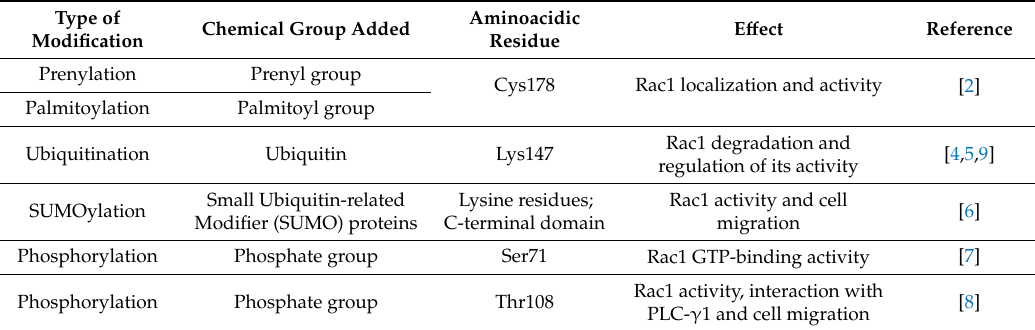
Table 1. Post-translational modifications of